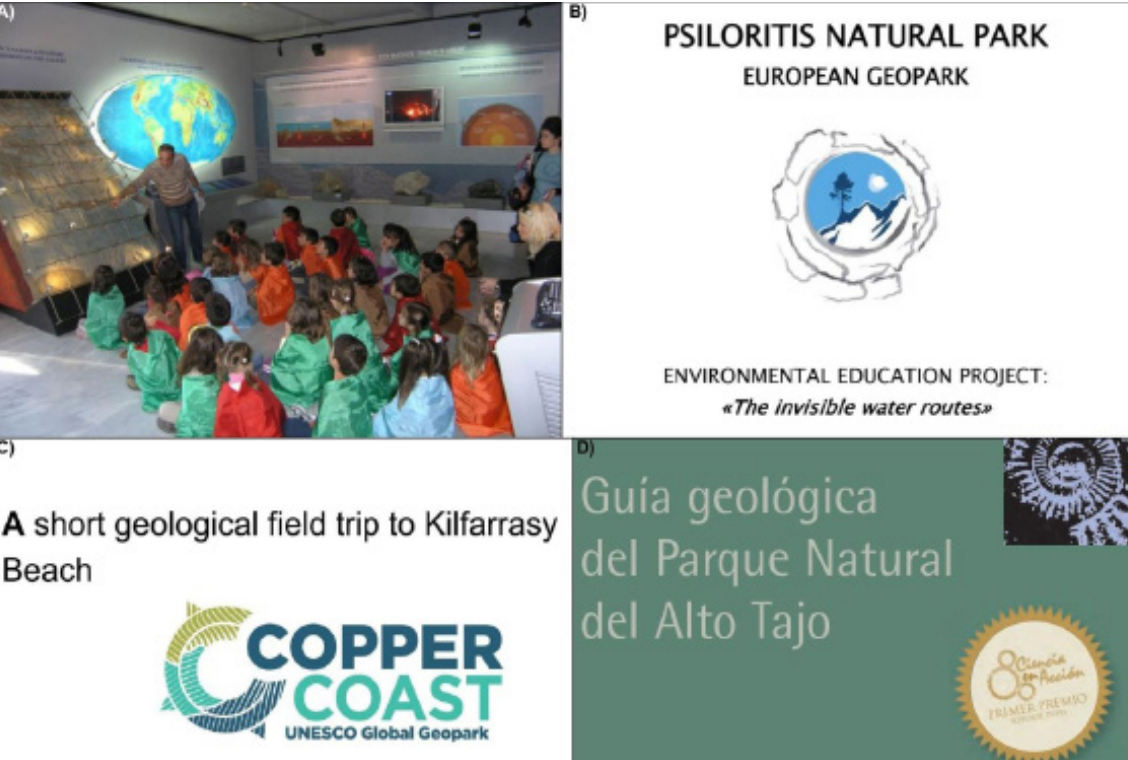
Figure 6. Examples of educational programs, field trips and geological guidebooks in UNESCO Global Geoparks. A) Students in the educational program on earthquakes at the Natural History Museum of the Lesvos Petrified Forest Geopark (Image from Zouros et al. 2011). B) Educational program on the invisible water routes at the Psiloritis Natural Park Global Geopark (Image from Fassoulas et al. 2007). C) Copper Coast Geopark field trips (Source: http://www.coppercoastgeopark.com/). D) Molina - Alto Tajo Geopark guidebook (Image downloaded from